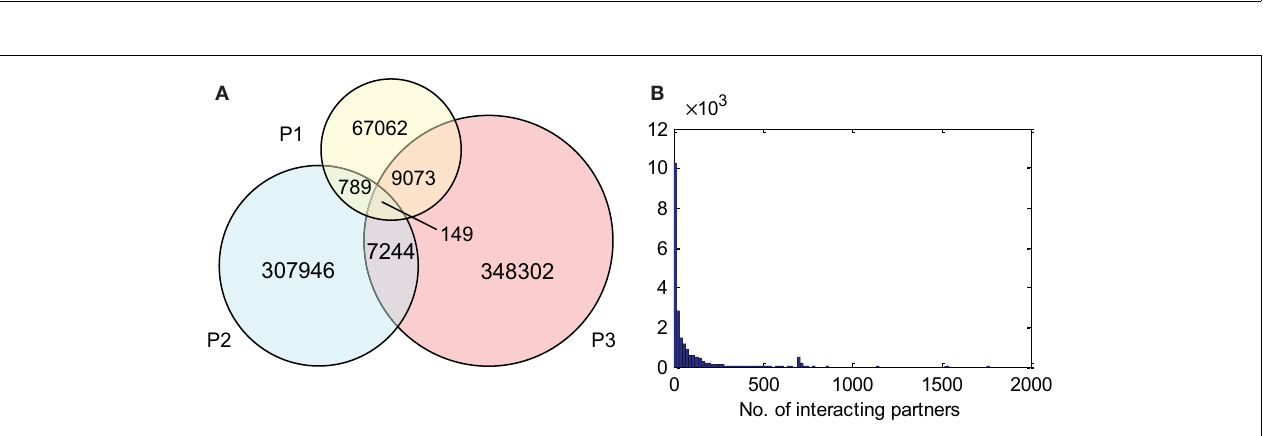
FIGURE 5 | Parameters for the MP algorithm had to be fine-tuned. (A) A priori probability β = 0.2 produces the minimum Bethe free energy. (B) For β = 0.2, minimum Bethe free energy was reached at ε = 0.02.